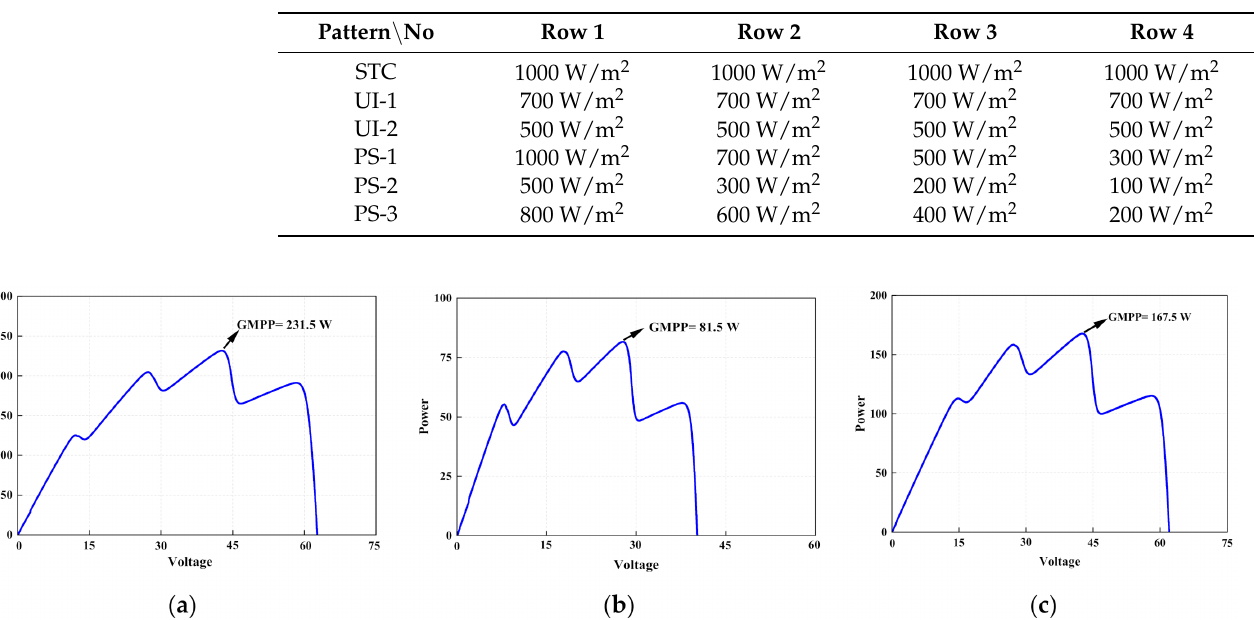
Figure 14. PV curves of non-uniform irradiance cases ( a ) PS-1, ( b ) PS-2, and ( c )